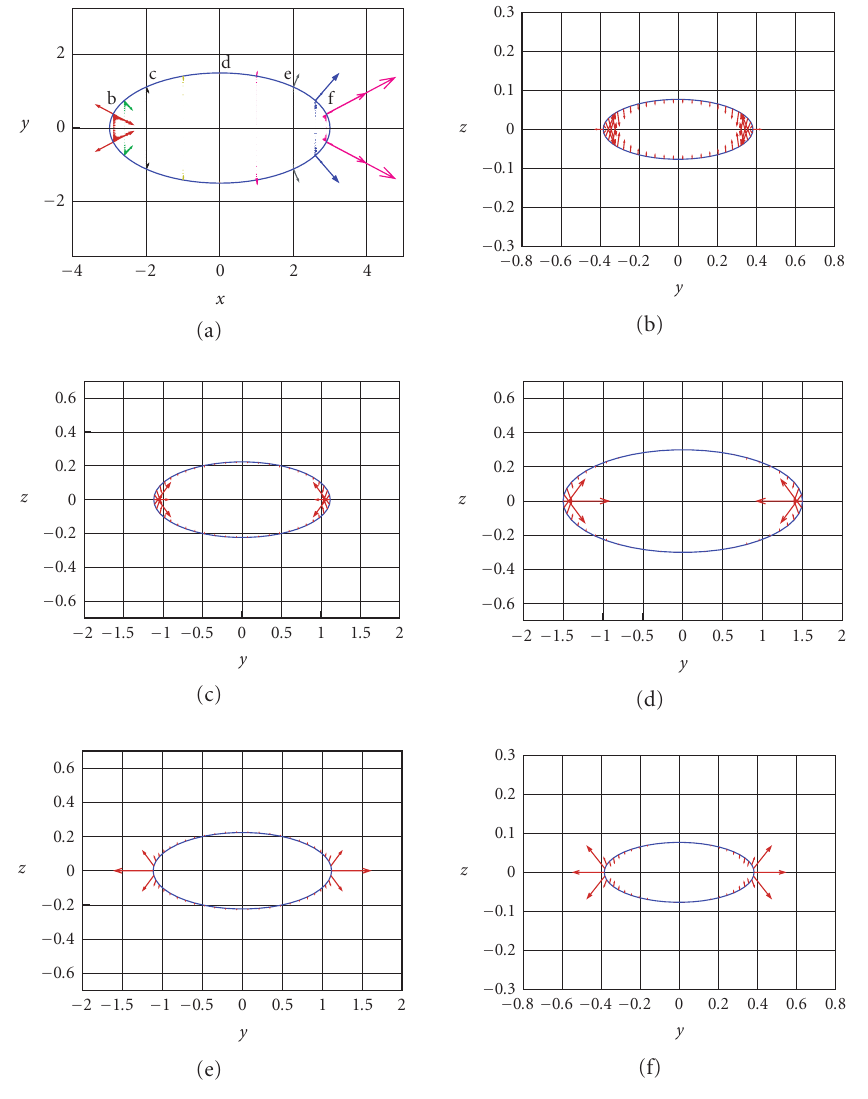
Figure 6.11. Distribution of the normal stress T nn on various cross sections on the ( y , z )-planes of an ellipsoid (with semiaxes a = 3, b = 1 . 5, c = 0 . 3 cm) immerse in a flow of fluid M1 (moving from left to right) with a Reynolds number of 0.05. (a) ( T nn n x + T nn n y ) / 1200dyn/cm 2 for an ellipsoid x 2 /a 2 + y 2 /b 2 = 1 − z 2 /c 2 with z = 0, in the ( x , y )-plane. (b) ( T y 2 /b 2 + z 2 /c 2 = 1 − x 2 /a 2 with x = − 2 . 9 cm, in the ( y , z )-plane. (c) ( T for an ellipsoid y 2 /b 2 + z 2 /c 2 = 1 − x 2 /a 2 with x = − 2 . 0cm, in the ( y , z )-plane. (d) ( T nn n y + n / 10dyn/cm 2 for an ellipsoid y 2 /b 2 + z 2 /c 2 = 1 − x 2 /a 2 with x = 0 . 0 cm, in the ( y , z )-plane. (e) T nn z ) ( T nn n y + T nn n z ) / 800dyn/cm 2 for an ellipsoid y 2 /b 2 + z 2 /c 2 = 1 − x 2 /a 2 with x = 2 . 0 cm, in the ( y , z )- plane. (f) ( T nn n y + T nn n z ) / 7500dyn/cm 2 for an ellipsoid y 2 /b 2 + z 2 /c 2 = 1 − x 2 /a 2 with x = 2 . 9 cm, in the ( y , z